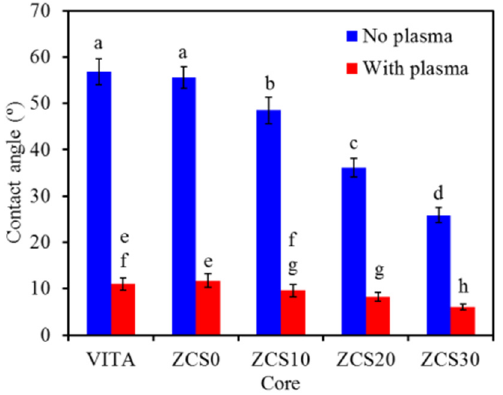
Figure 4. Water contact angle values of different core substructures before and after plasma treatment. Different lowercase letters show statistically significant differences at p < 0.05 (n = 10).